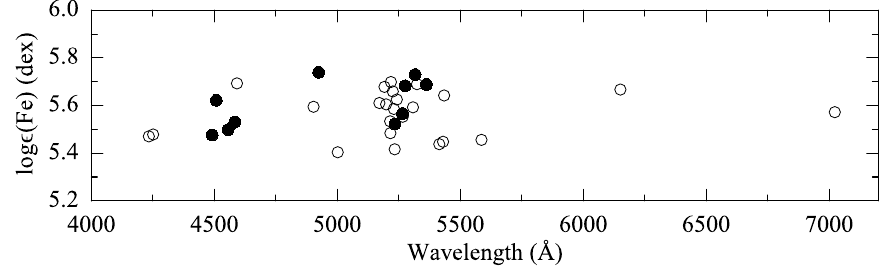
Fig. 23. The idividual abundances calculated for each Fe I ( ◦ ) and Fe II ( • ) line using the final atmospheric parameters.